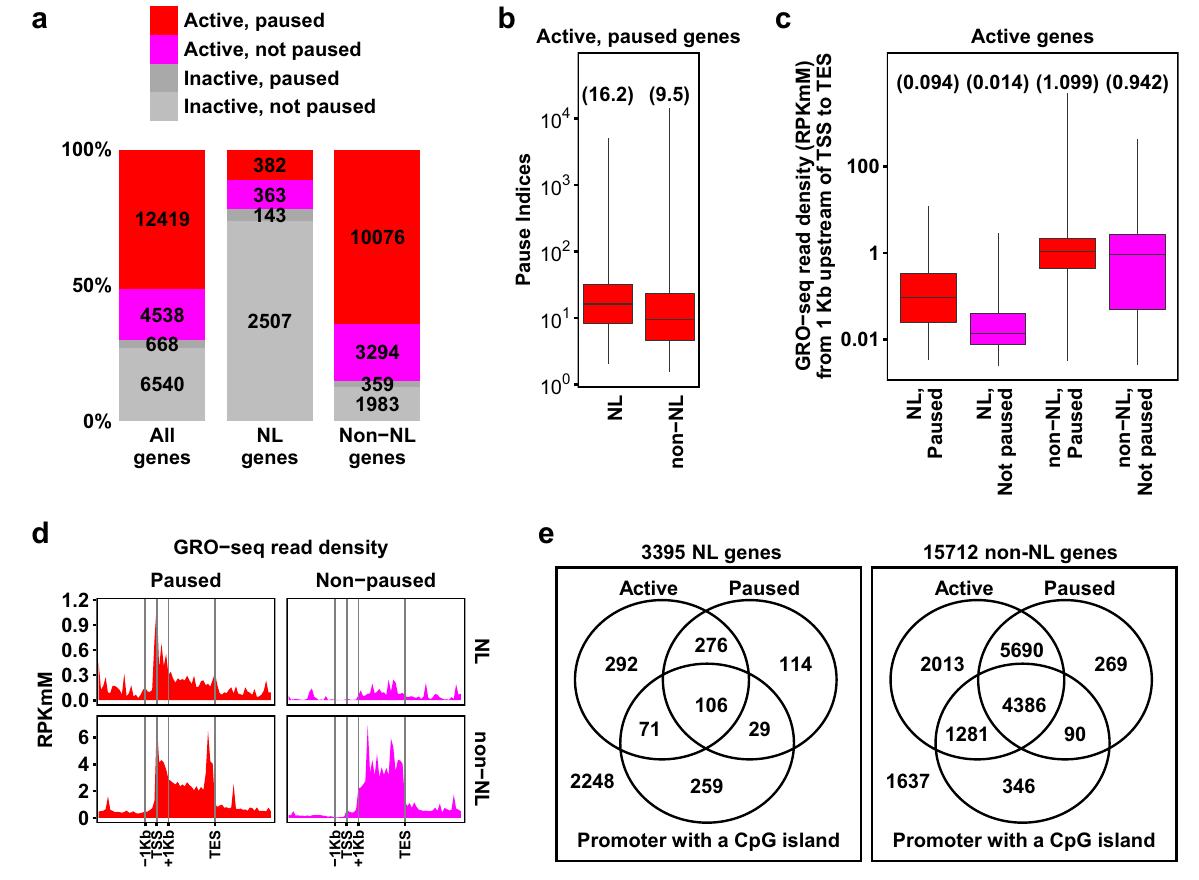
Figure 4. Detecting RNA Pol II promoter-proximal pausing among NL genes. ( a ) Numbers and percentages of genes grouped by gene activity, NL-association and Pol II pausing status. ( b ) Box plot comparing pause indices between active, paused NL genes and active, paused non-NL genes. ( c ) Box plot comparing Pol II recruitment levels among active NL genes and active non-NL genes grouped by their pausing status. In panels b and c, the minimum and the maximum values are presented by whisker ends and the quartiles by box boundaries. The median values are shown in parentheses. Paused genes have significantly higher Pol II recruitment than non-paused genes among both NL and non-NL genes (Mann-Whitney test, p-values < 2.2e-16). ( d ) Average GRO-seq read densities along genic regions of paused and non-paused NL/non-NL genes. Data are binned as described in Fig. 3b. ( e ) Venn diagrams showing distributions of NL and non-NL genes according to gene activity, RNA Pol II pausing and CpG island-containing promoters. Genome coordinates of CpG islands in mouse genome assembly mm9 were downloaded from UCSC genome browser. A CpG island-containing promoter was defined by the existence of a CpG island within ± 1 Kb of a TSS 15